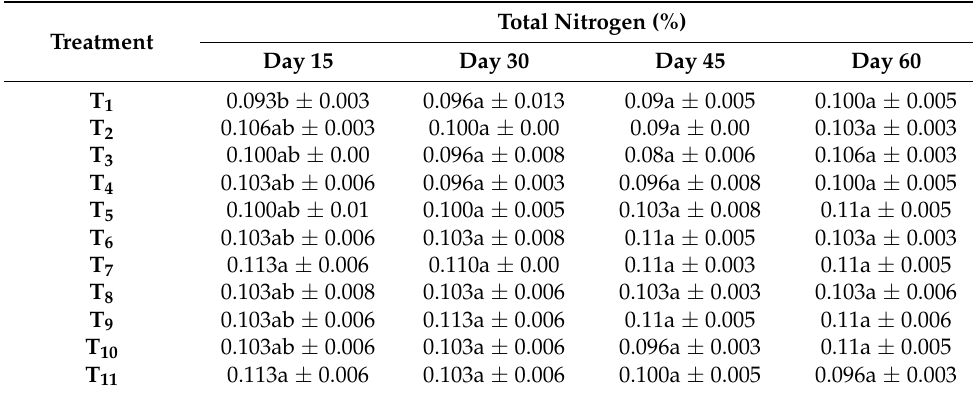
Table 6. Effect of RHB, EFBB, and dolomitic limestone treatments on soil total nitrogen.